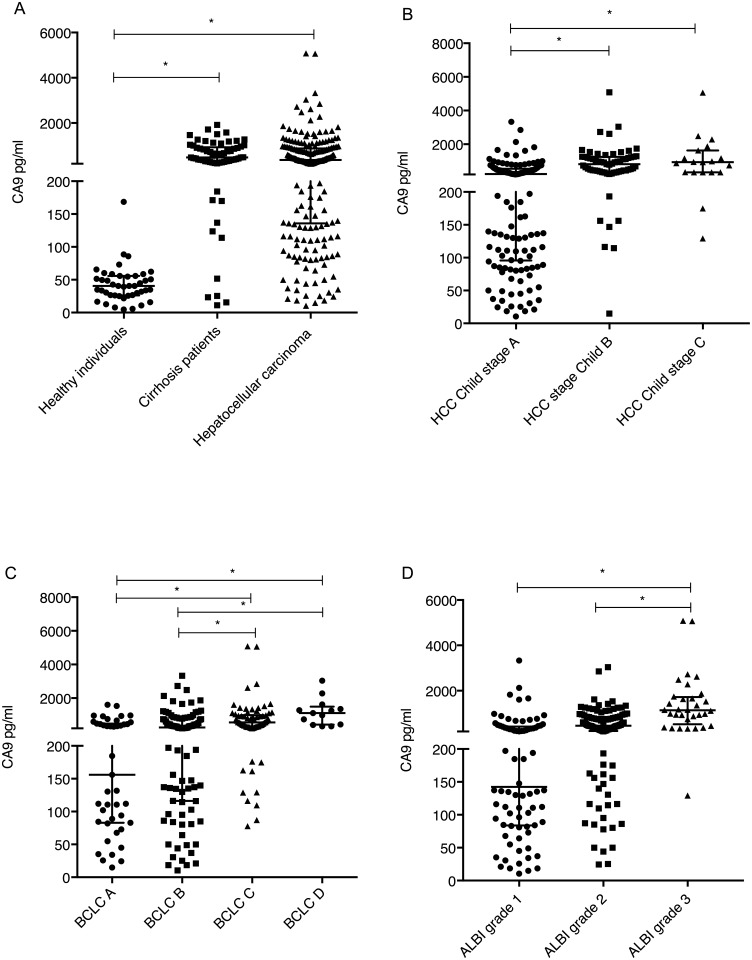
CA9 levels in HCC patients.A CA9 levels in healthy patients, patients with cirrhosis only and patients with hepatocellular carcinoma. B CA9 levels in different stages of Child Pugh in HCC patients. C CA9 levels in different stages of HCC according to BCLC. D CA9 levels in different stages of HCC according to ALBI score. (*, P<0.01). Vertical lines indicate the range, the horizontal boundaries of the boxes represent the first and third quartile.